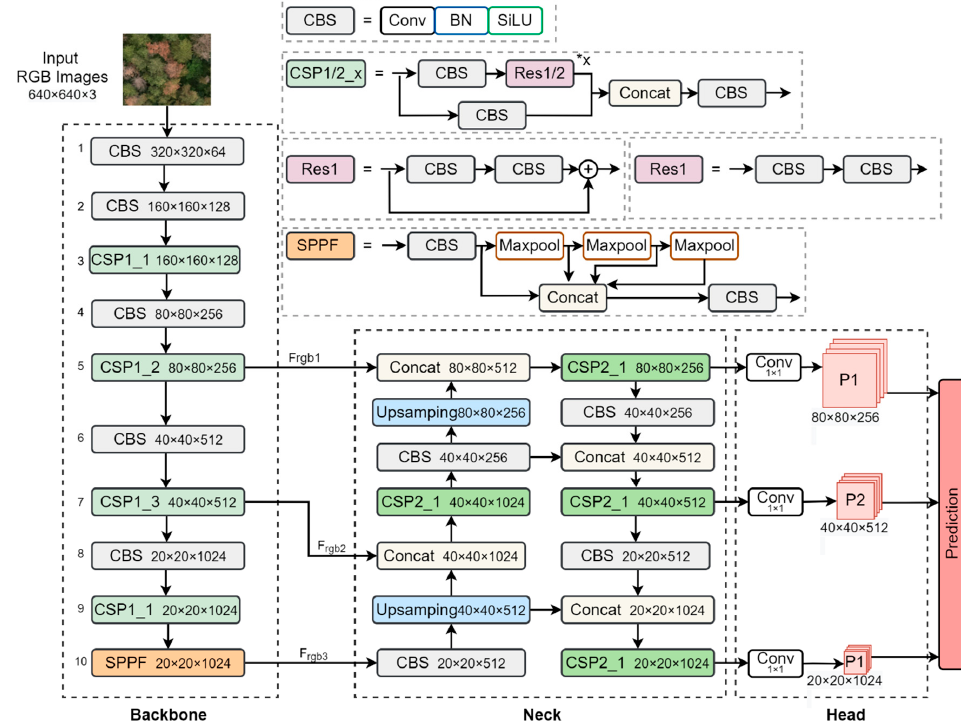
Figure 7. Structure of YOLOv5l network.